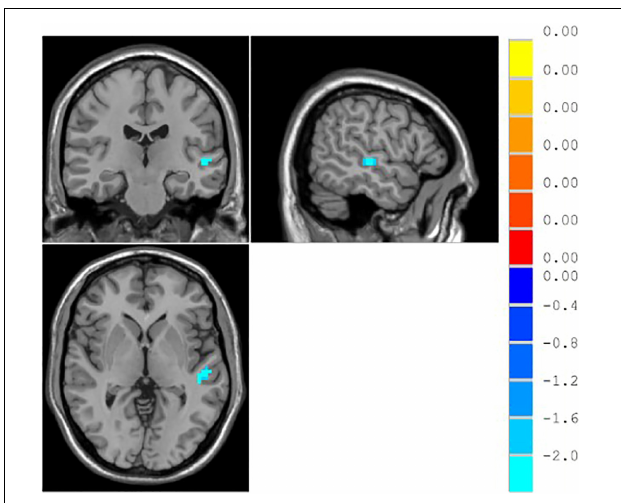
FIGURE 6 | | Brain regions with different functional connectivity between the responsive and unresponsive groups.